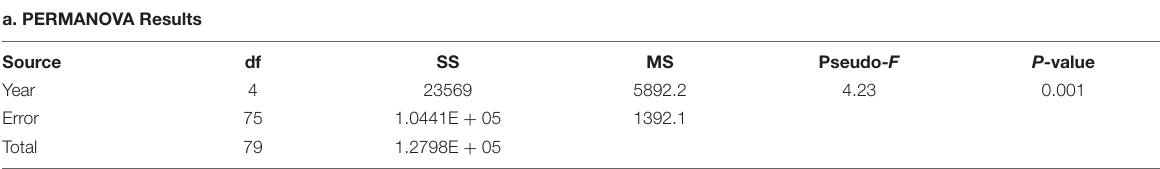
TABLE 3 | Results of a PERMANOVA testing differences in fish community structure across 5 years at the site of the Hui Feng